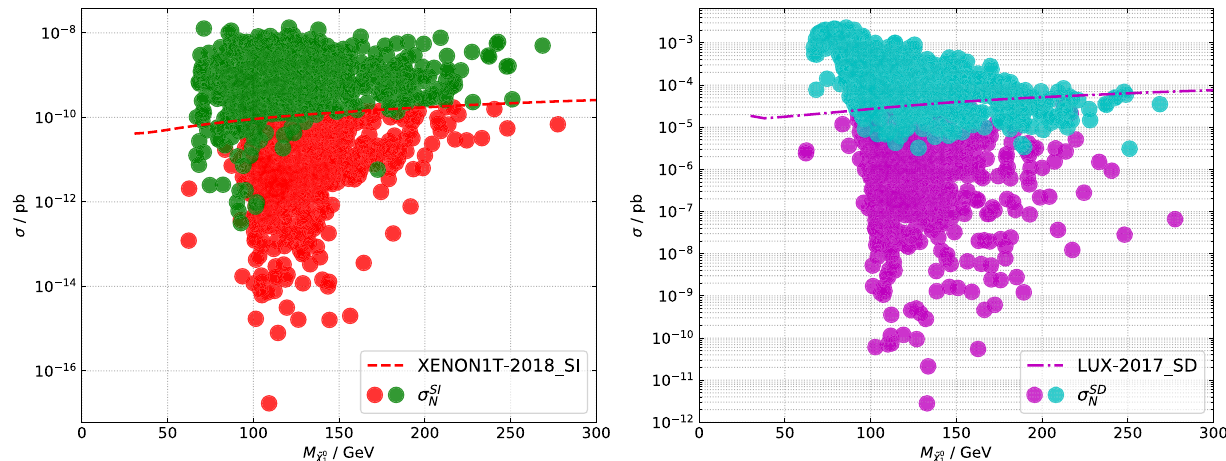
dashed line represents the limit from XENON-1T-2018. In the right plane, the magenta dash-dotted line represents the limit from LUX-